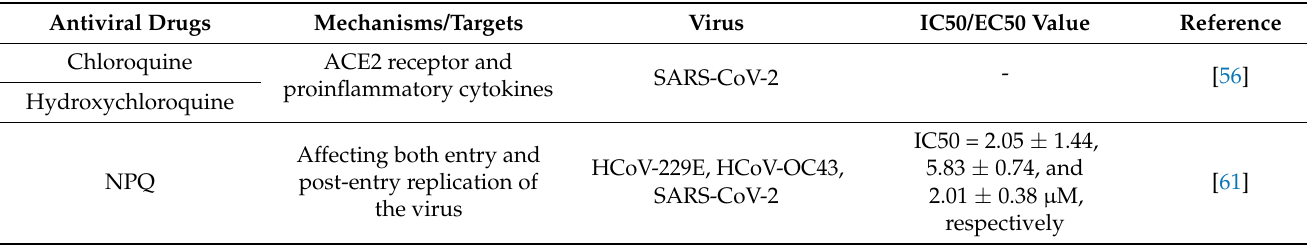
Table 3. Antiviral antimalarial drugs and the antiviral